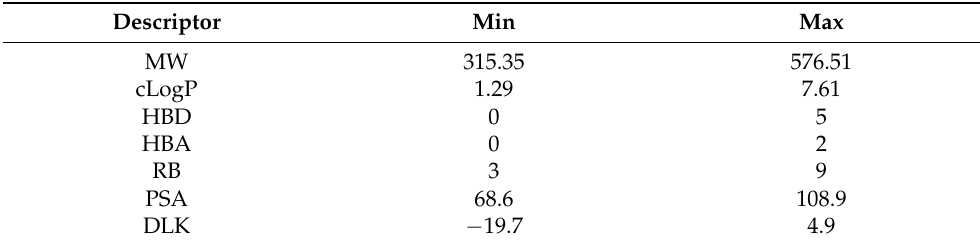
Table 4. Descriptive statistics for the molecular